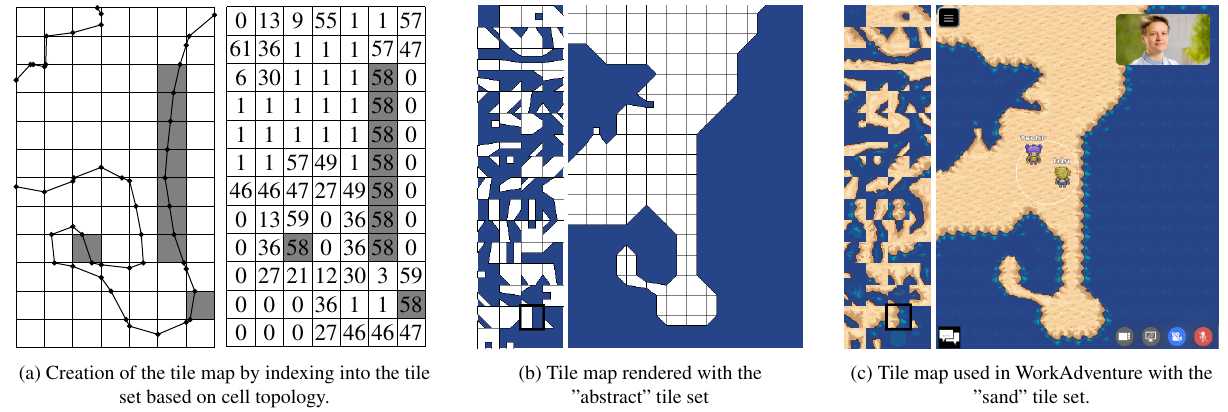
Figure 3. Creation of the indexed tile map and use with different tile sets. The tile with index 58 is highlighted in the map and tile set. and also in the tile sets shown in Figures 3b and 3c. This tile corresponds to a cell with exactly one segment running from the bottom (south) border to the top (north) border of the cell (with land to the left and water to the right). The tile with index 36, for another example, has one segment as well, running the opposite direction from top to bottom of the